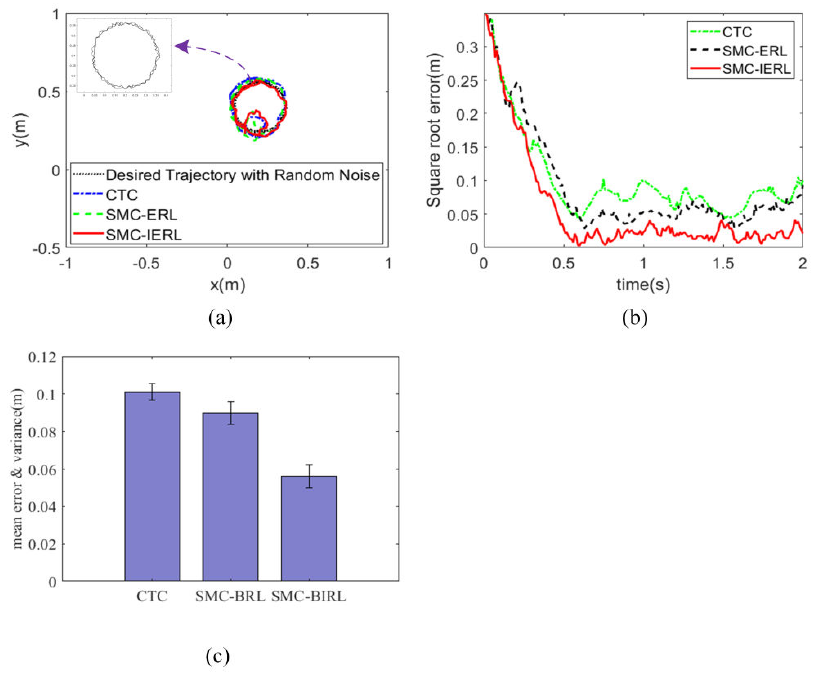
Figure 9. Non-uniform circular trajectory tracking experiment without considering disturbance signal. ( a ) comparison of trajectory tracking for desired non-uniform circular trajectory with three control algorithms; ( b ) comparison of square root error of three control algorithms; ( c ) comparison of mean error and variance of three control